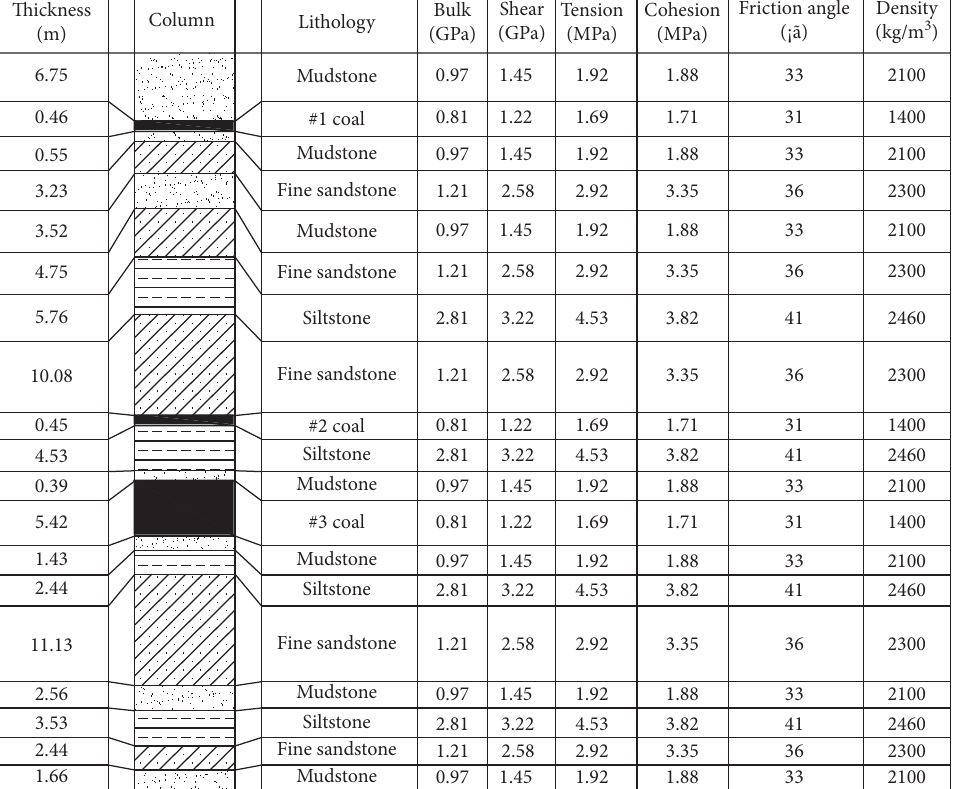
Figure 1: Coal seam stratum synthesis histogram.